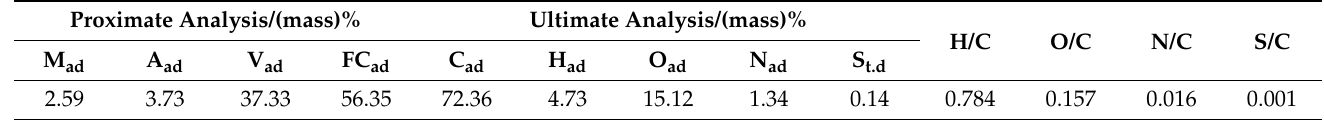
Table 1. Table 1. Proximate and ultimate analyses of Kerjian